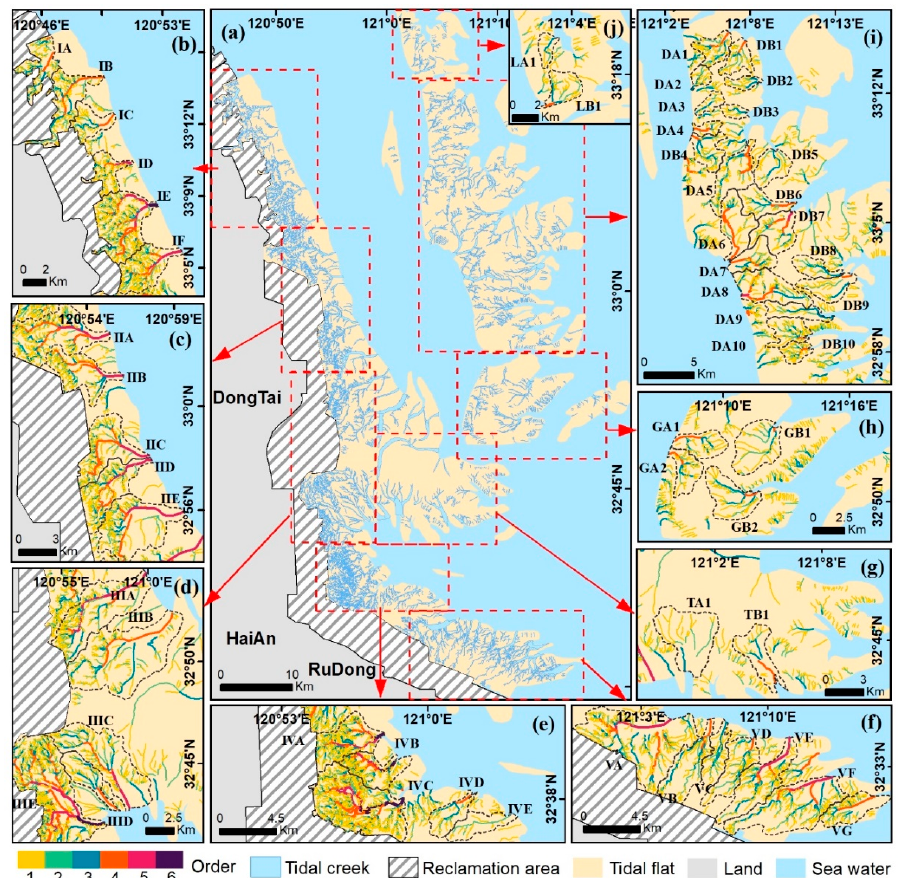
Figure 5. Results of tidal creek extraction and ordering. ( a ) Distribution of tidal creeks and N-S zonation of the tidal flats. ( b – j ) Delineation and ordering of typical tidal basins. ( b – f ) are coastal tidal creeks and ( g – j ) are o ff shore tidal